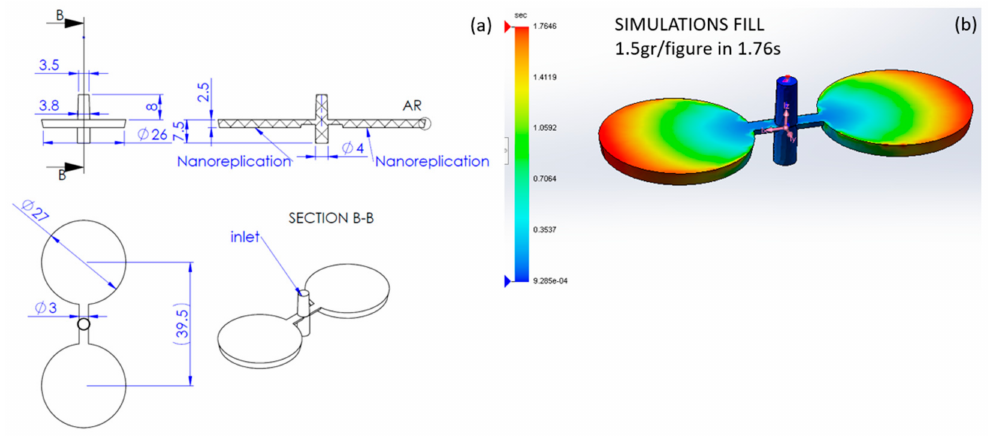
Table 1. Steel mold and PP polymer thermal material properties used in simulations. Figure 1. Plastic injection ( a ) basic dimensions and ( b ) macroscale simulation.